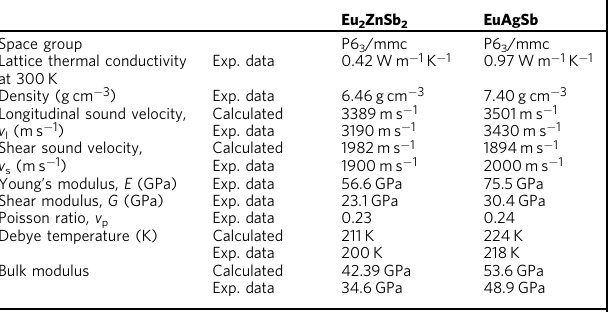
Table 1 Physical properties of Eu 2 ZnSb 2 and